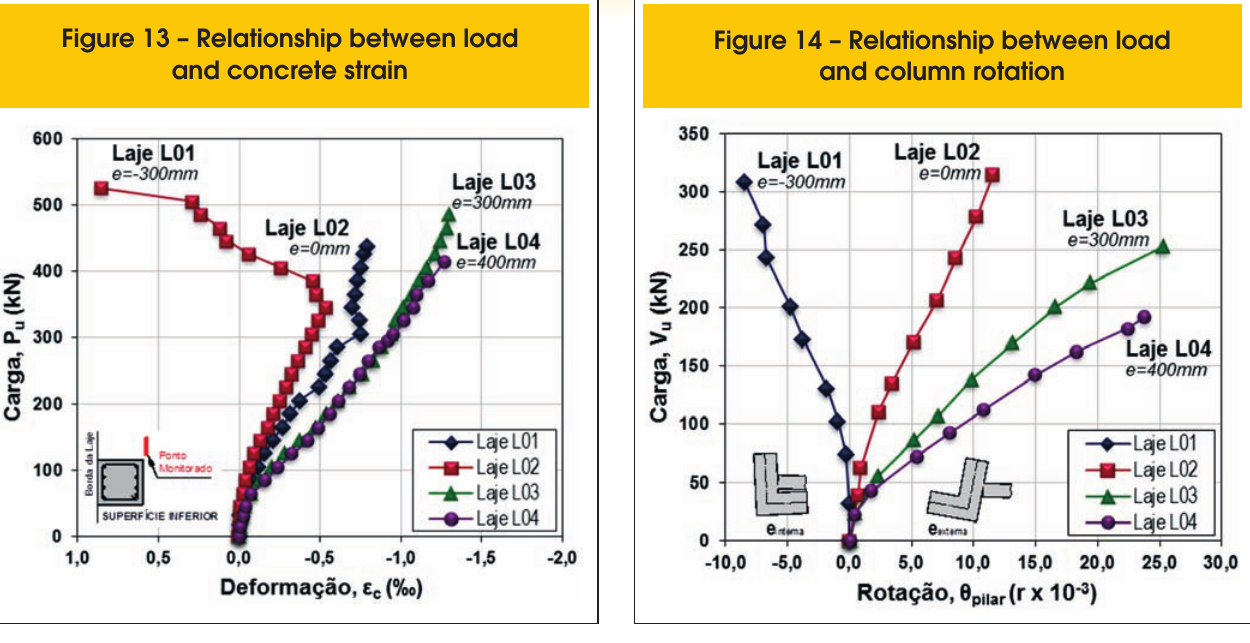
Figure 13 – Relationship between load and concrete strain